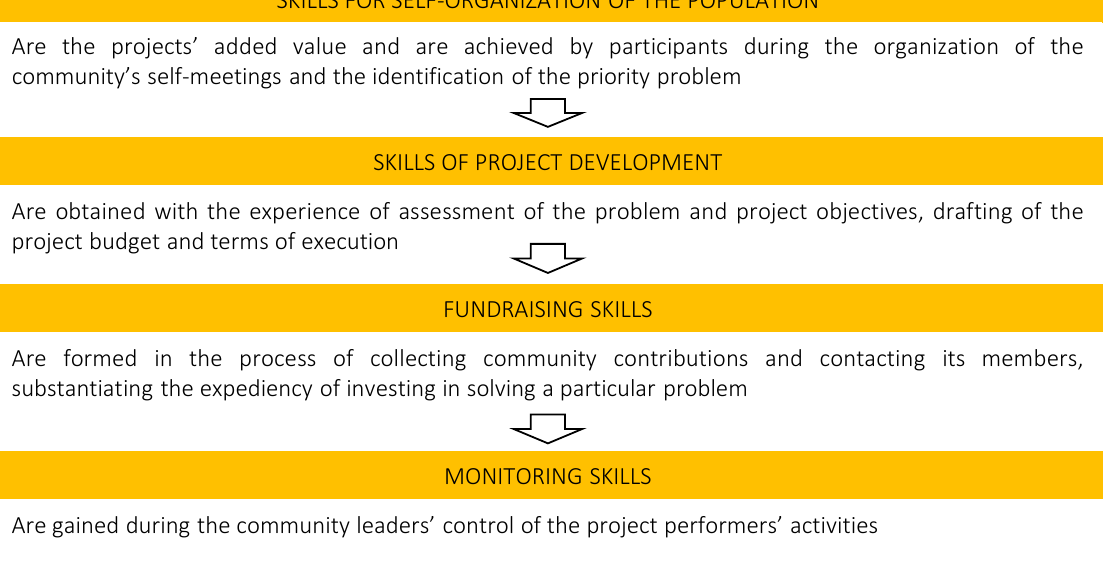
Figure 3. Methodology for acquiring impact investing skills